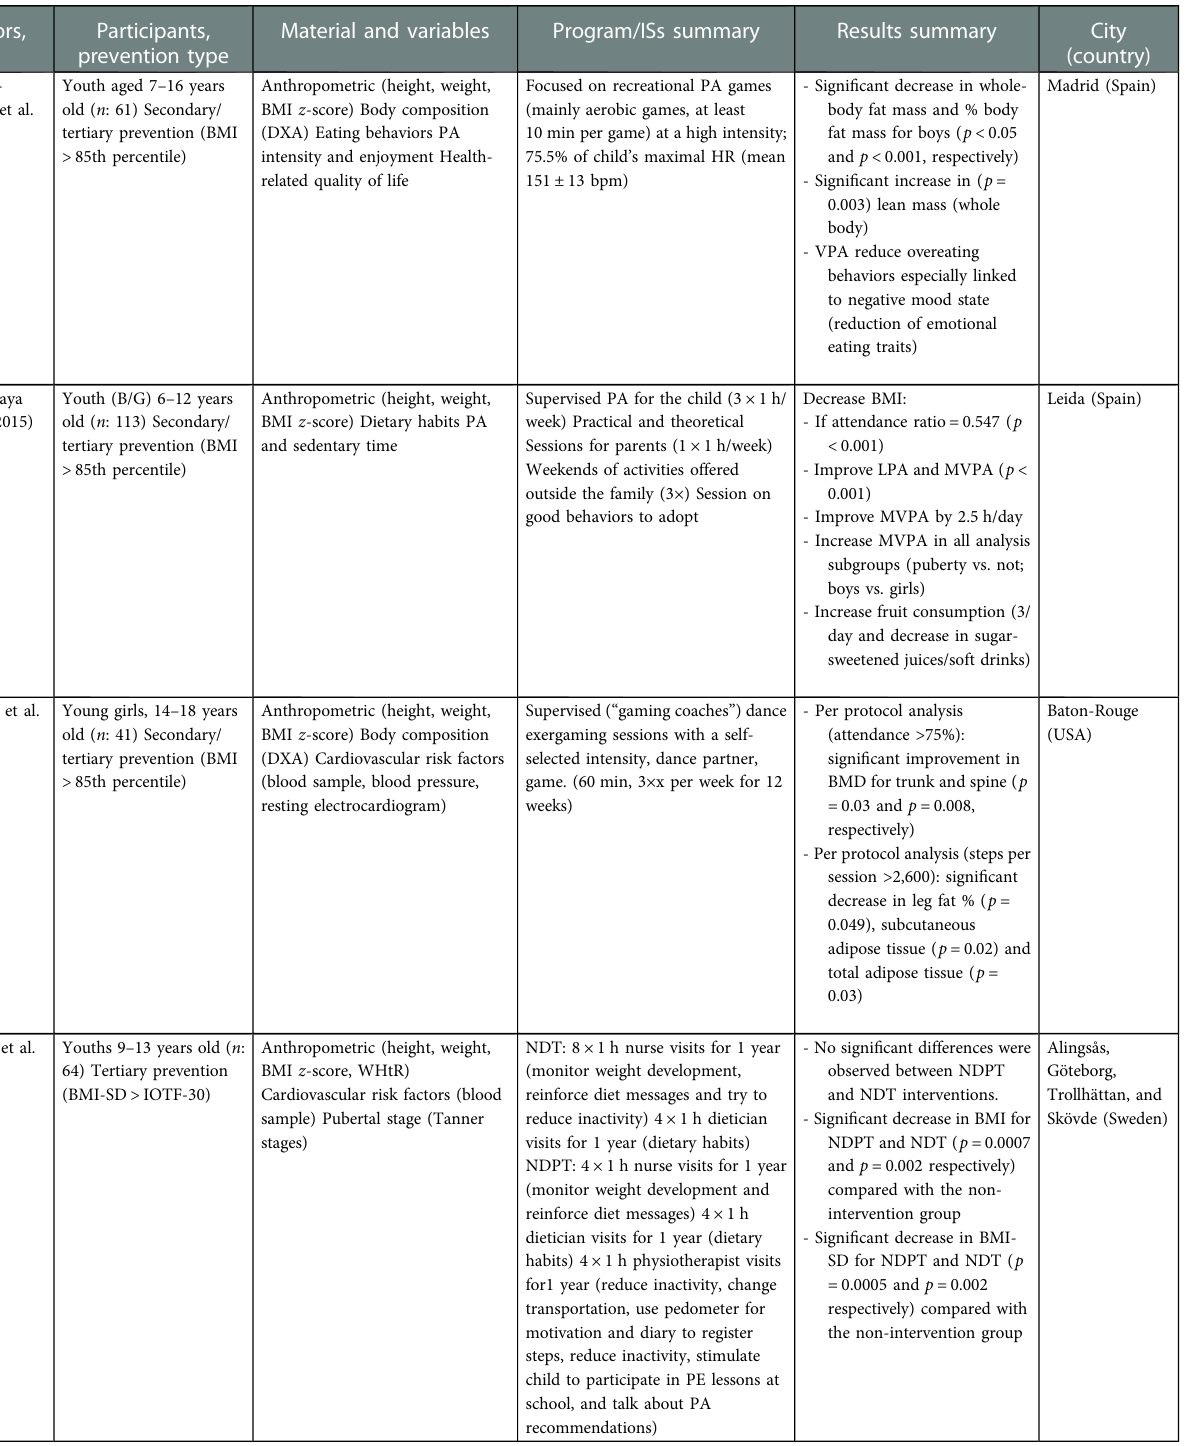
TABLE 2 Illustrations of studies for clinical